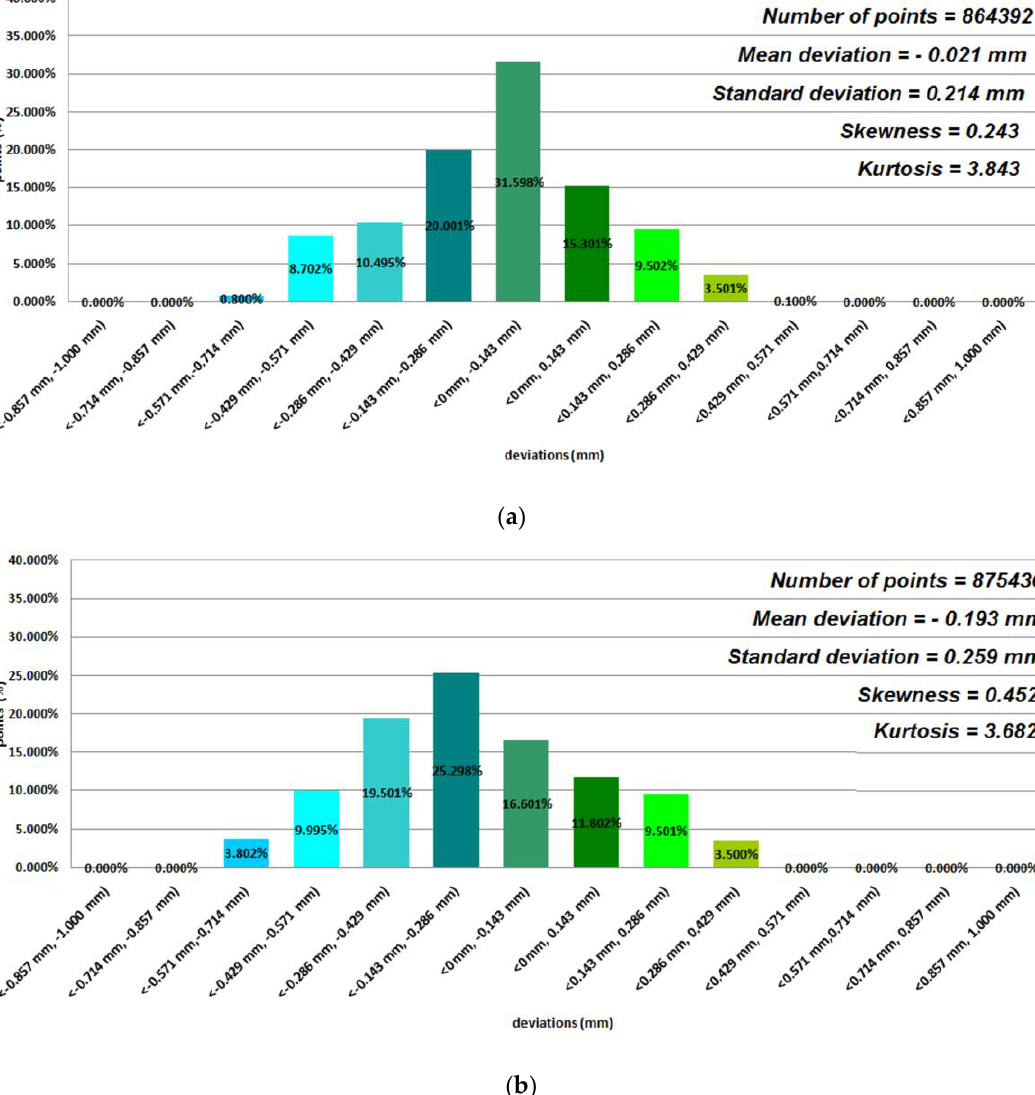
( c ) Figure 4. Histograms representing average results of the 12 mandible structures: ( a ) ABS M-30 material; ( b ) PC-10 material; ( c ) Polylactic acid (PLA) material.